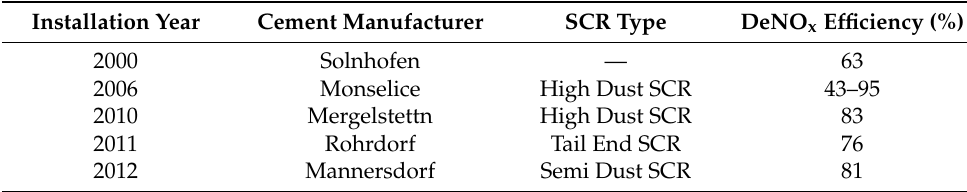
Table 5. Examples of cement manufacturers with an SCR process.